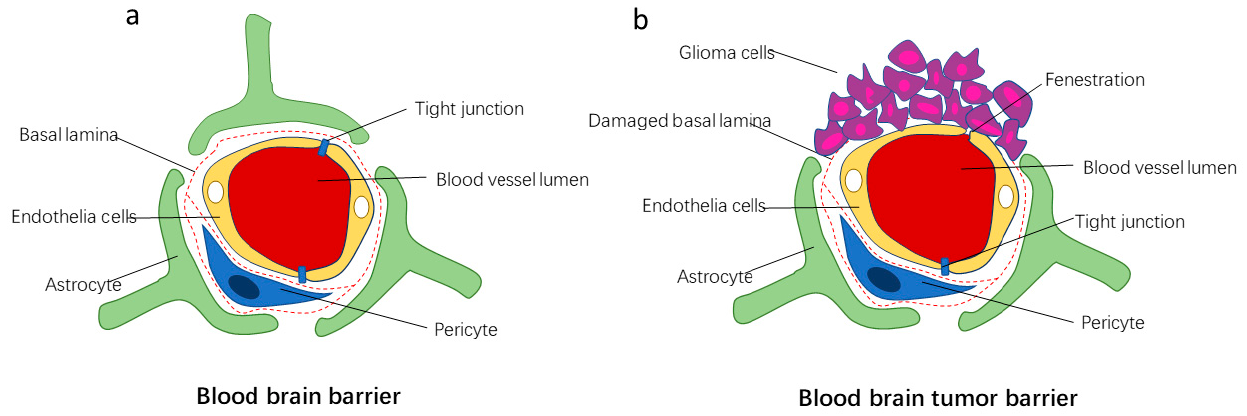
Figure 1. Schematic of composition and structure of blood–brain barrier and blood–tumor barrier.